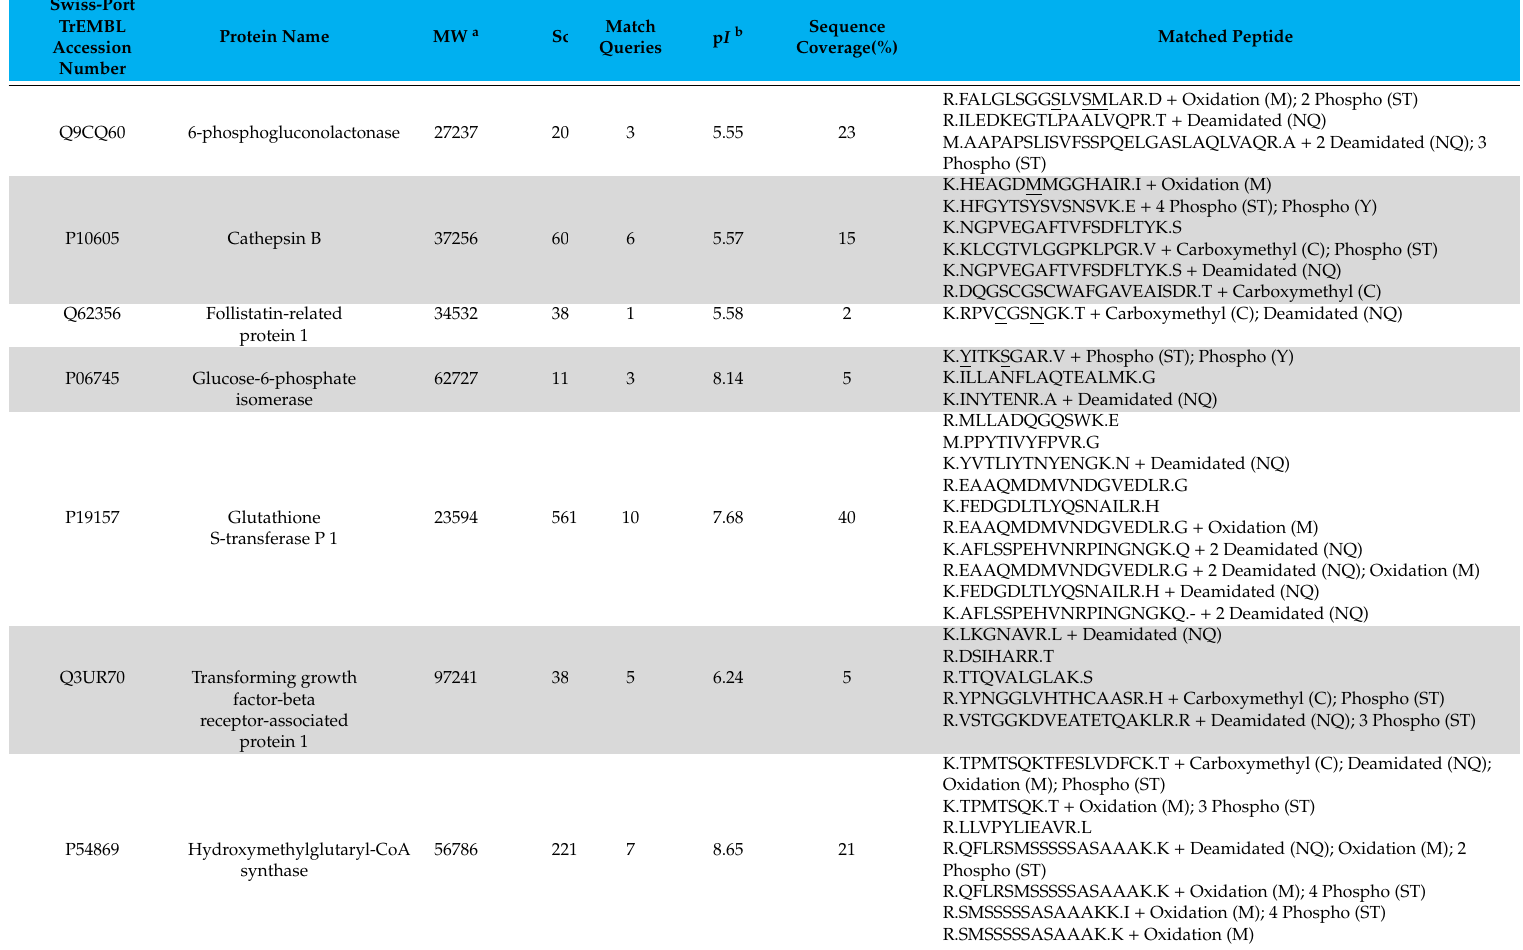
Table 1. Summary of proteins corresponding to tumorigenesis in HBx